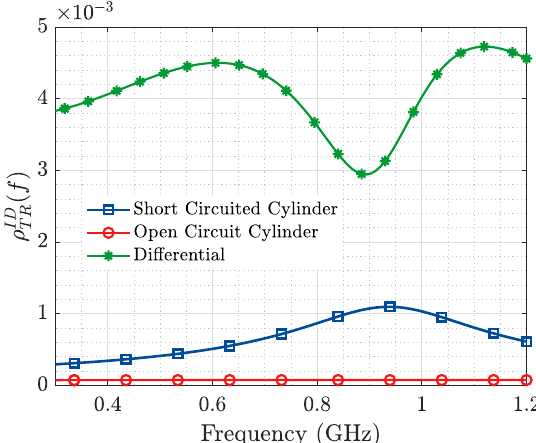
( f ) of a 20 mm conducting cylinder representing the ID. The resonance is distinguished Figure 2. ρ ID TR when the ID is fully operational (continuous object or Z ID = 1000). The interferent differential signal is also reported. (breakdown or Z ID LD